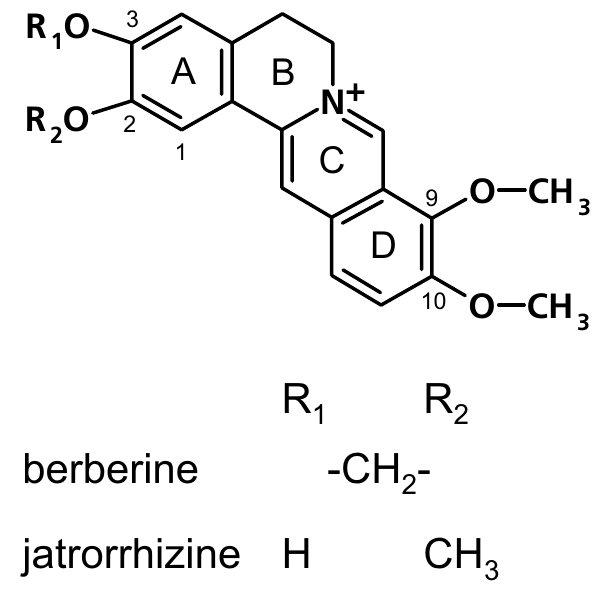
Figure 1 Chemical structures of berberine and